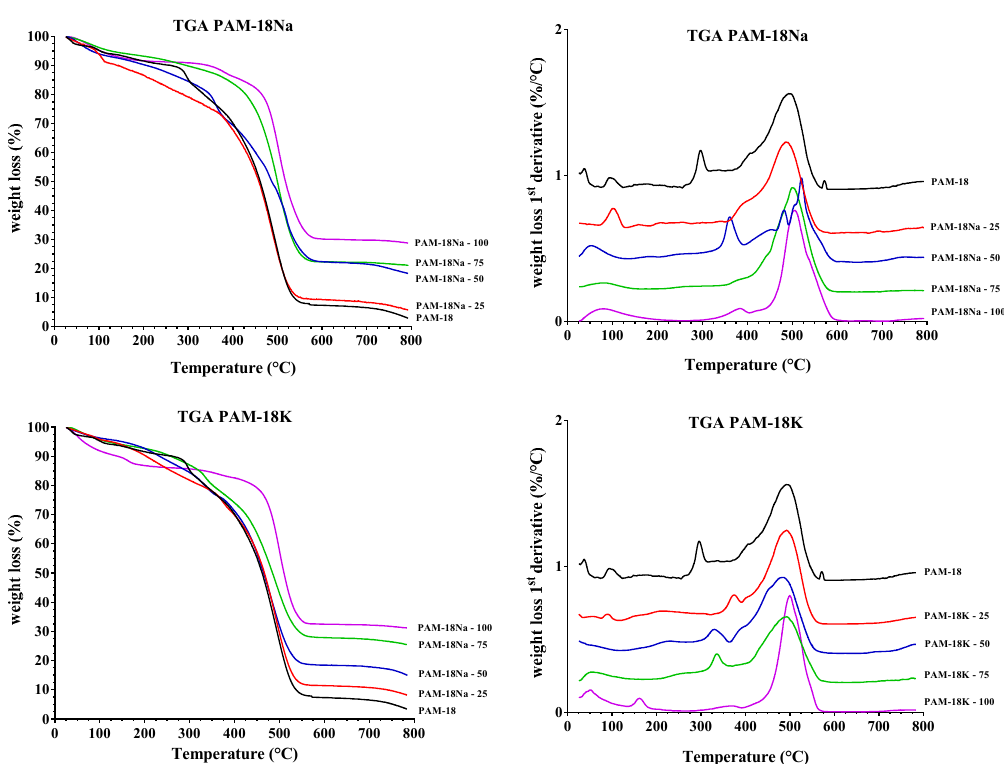
Figure 4. Thermogravimetric analysis (TGA) of polymers derived from PAM-18.